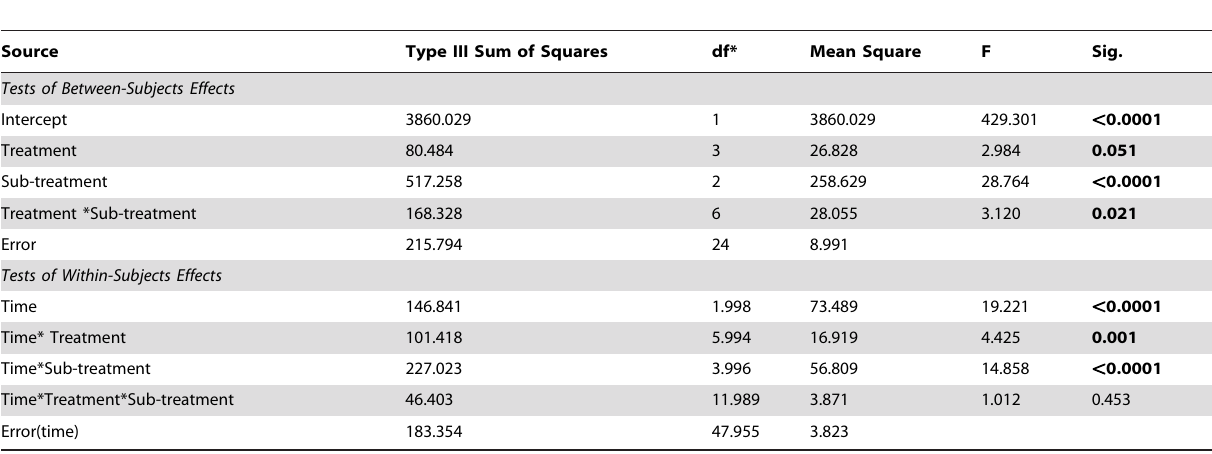
Table 2. Repeated-measures two-way ANOVA of the recorded aphid numbers with treatment (initial aphid densities) and sub- treatment (‘‘Predators’’, ‘‘Predators + Parasitoids’’ and ‘‘Parasitoids’’) counted as main effects.